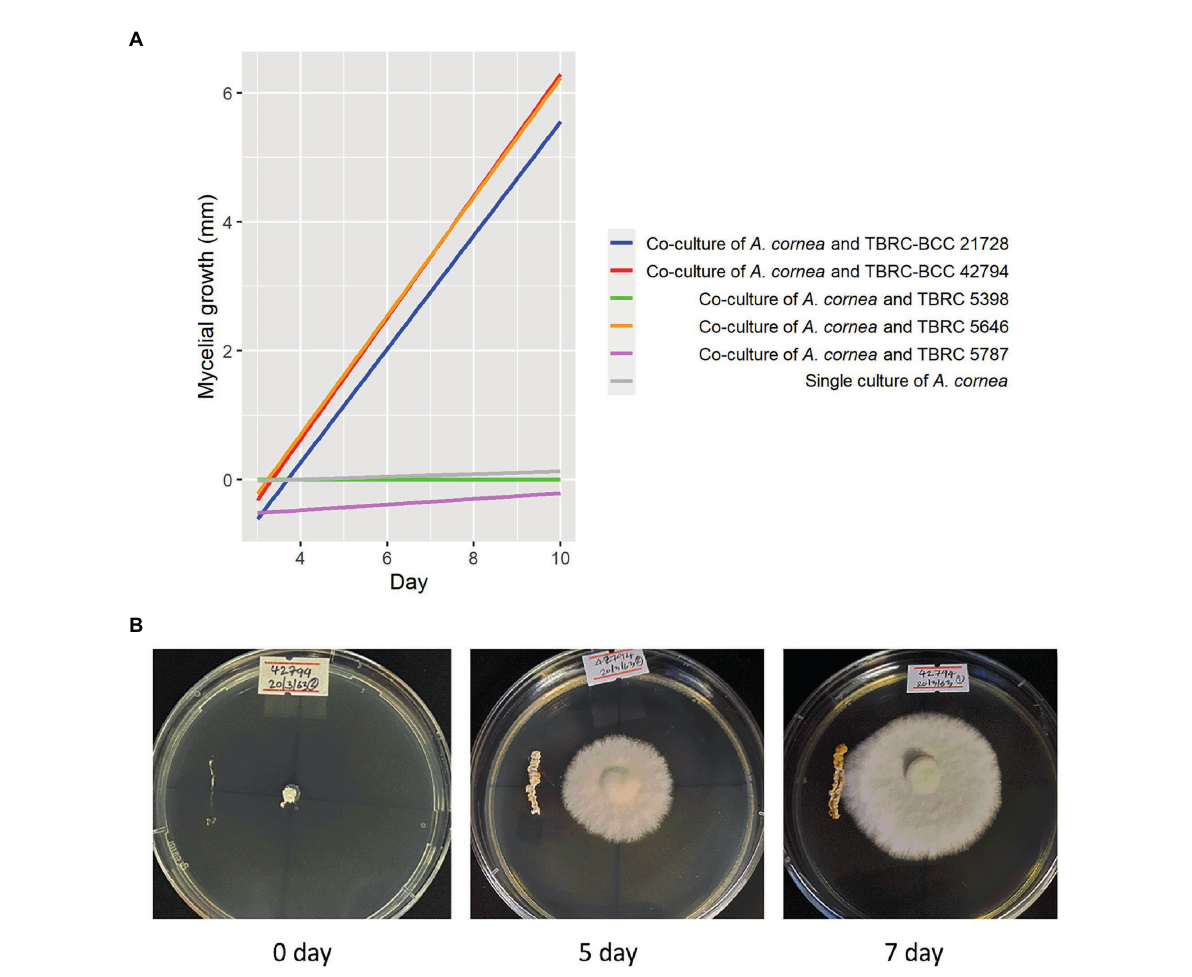
FIGURE 5 Effects of bacteria on the growth of A. cornea in the co-culture conditions on solid agar medium. (A) Linear regression lines showing A. cornea mycelial growth in the co-culture conditions are displayed as differences between mycelial length on the side towards the bacterial colony and on the side away from the bacterial colony in the graph. In the co-culture conditions, A. cornea TBRC 12900 was co-cultured with P. mangrovi TBRC-BCC 42794 (red line), P. antitumoralis TBRC-BCC 21728 (blue line), M. lotononidis TBRC 5398 (green line), P. antitumoralis TBRC 5646 (orange line), or S. yanoikuyae TBRC 5787 (pink line). The mycelial growth in the single culture of A. cornea (gray line) was used as a negative control. (B) Co-culture of A. cornea TBRC 12900 and P. mangrovi TBRC-BCC 42794 resulted in elevated mycelial growth on agar medium near the P. mangrove line streak (shown on day 5 and day 7 after the